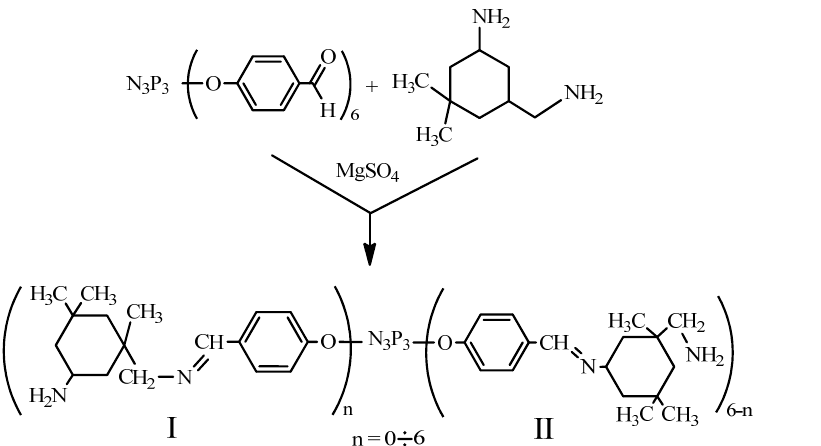
Figure 1. Scheme of reaction between FPP and IPDA.